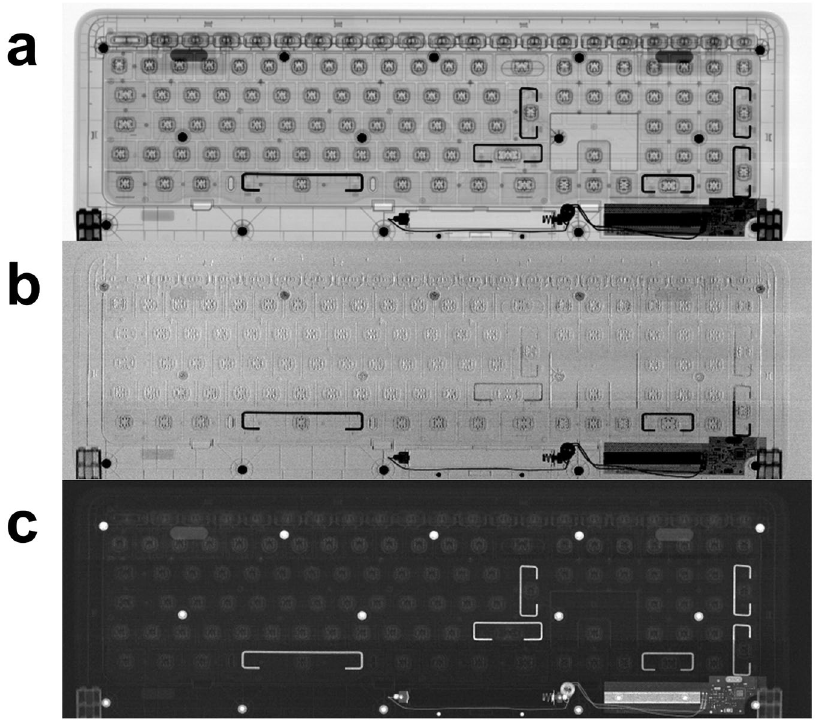
Figure 2. Example of a large field of view fast scan. The three retrieved images of a keyboard sample: (a ) attenuation, ( b ) differential phase and ( c ) dark-field images (sample size 46 × 16 cm 2 ; the sample was scanned along the longest (horizontal)